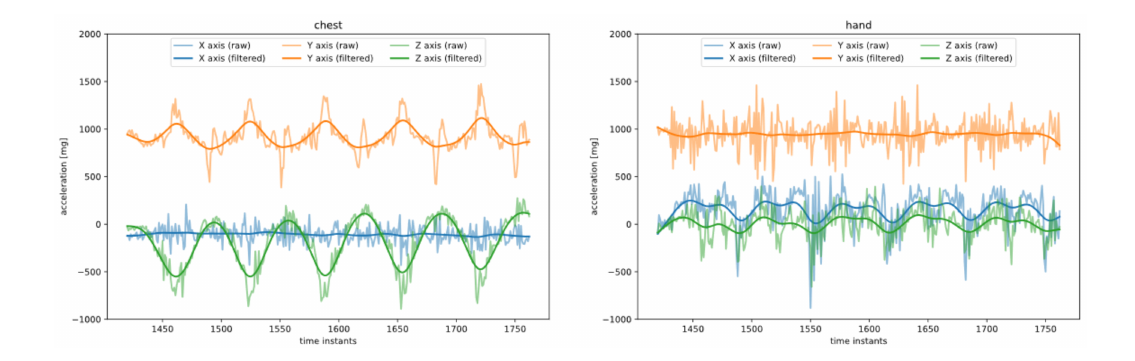
Figure 8. Acceleration signals from chest and hand sensors before and after